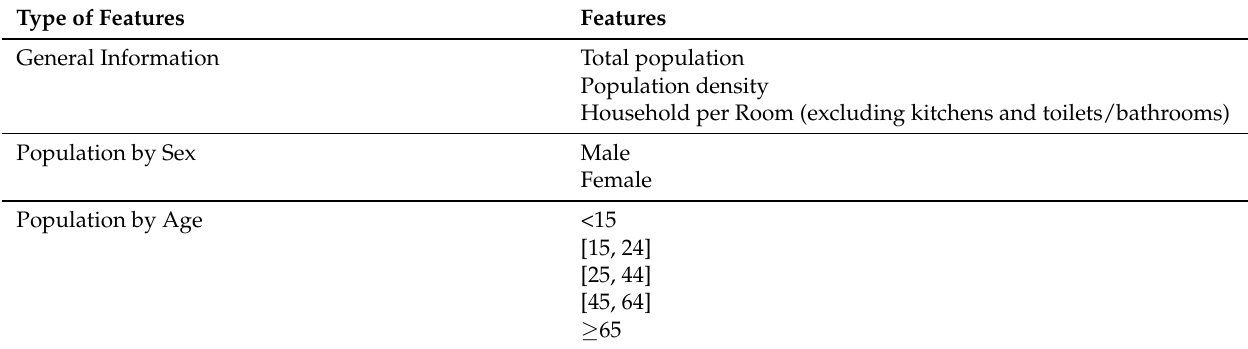
Table 1. Population